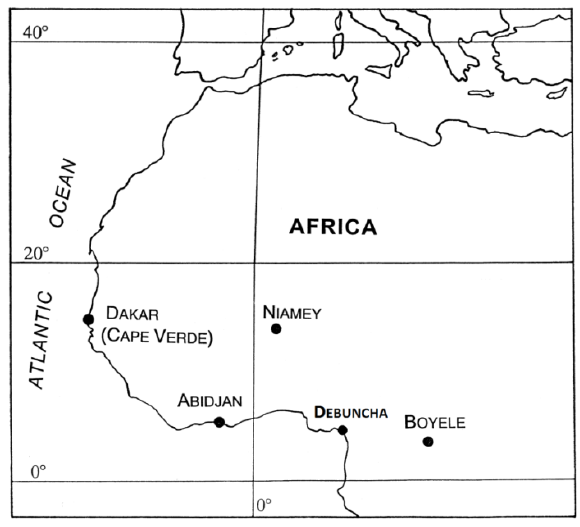
Figure 4. Location of the data collection sites.